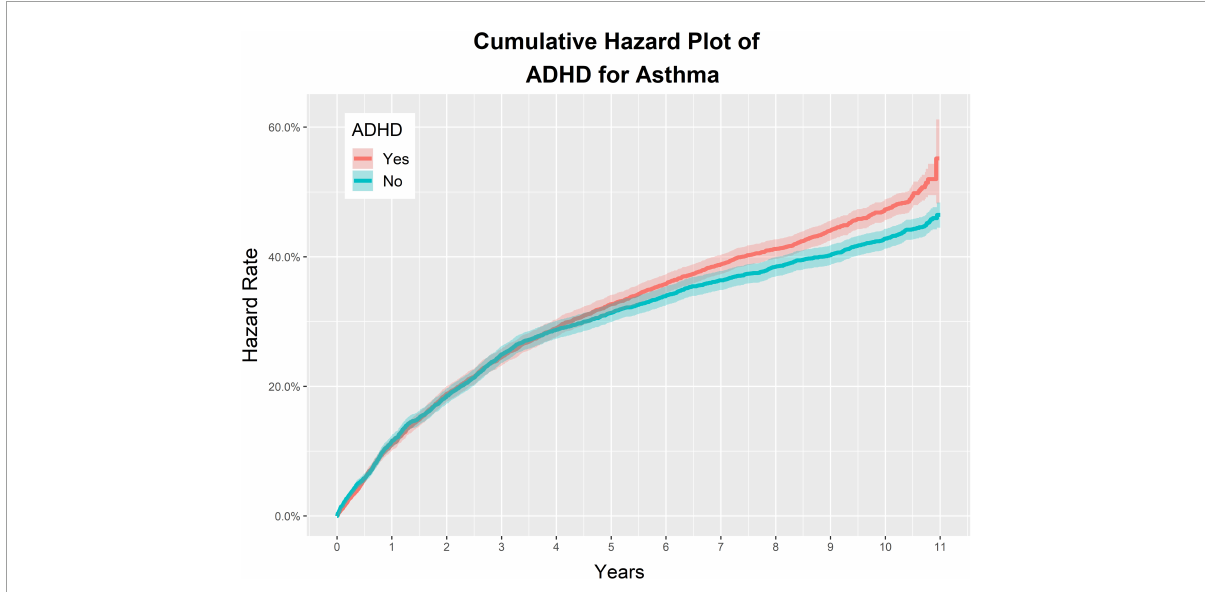
FIGURE4 Study 2. Overall cumulative hazard rate for asthma in the ADHD group and the non-ADHD